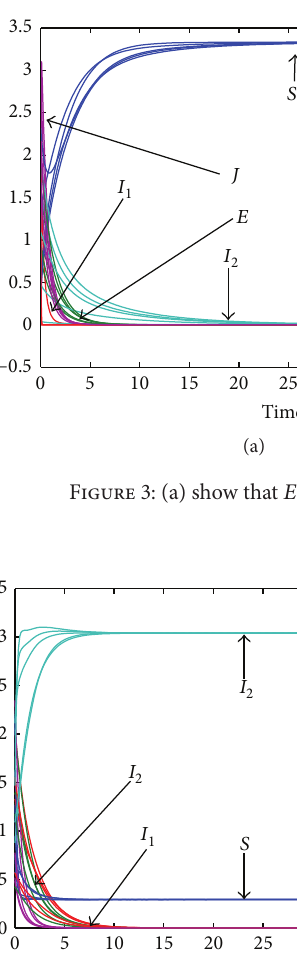
𝛼 = 0.01 , 𝛼 = 0.03 . We have 𝑅 1 2 = 0.33470 , which satisfies the conditions of Theorem 7. 𝐸 𝑅 1 should be globally asymptotically stable (see left of Figure